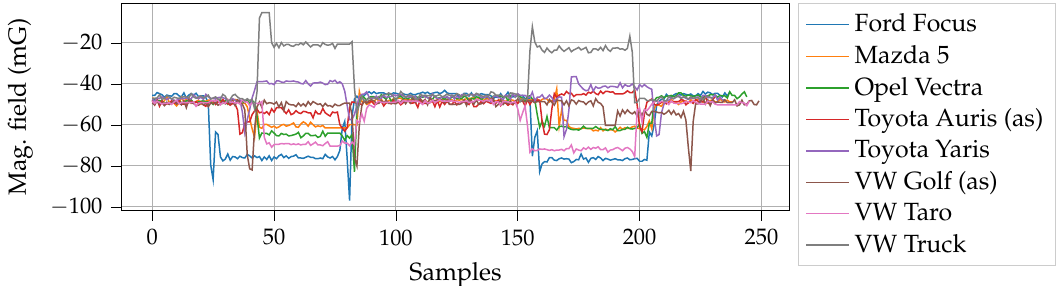
Figure 10. Variation in accelerometer and magnetometer readings sensed by our prototype parking sensor node when a vehicle enters and leaves the parking slot. Here, Ax, Ay, Az indicate 3-axes acceleration changes, and Mx, My, Mz indicate 3-axes magnetic field changes.